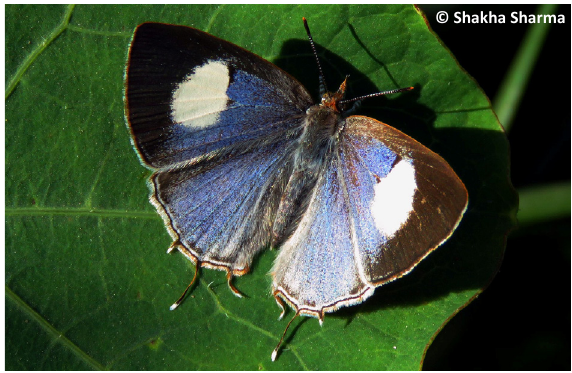
Image 4. Common Onyx Horaga onyx onyx (Moore,